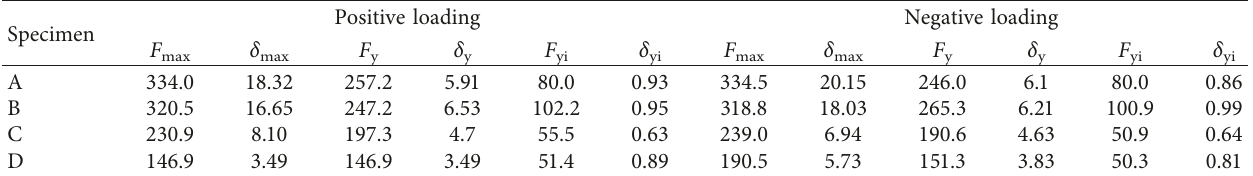
Table 2: Characteristic results [16].